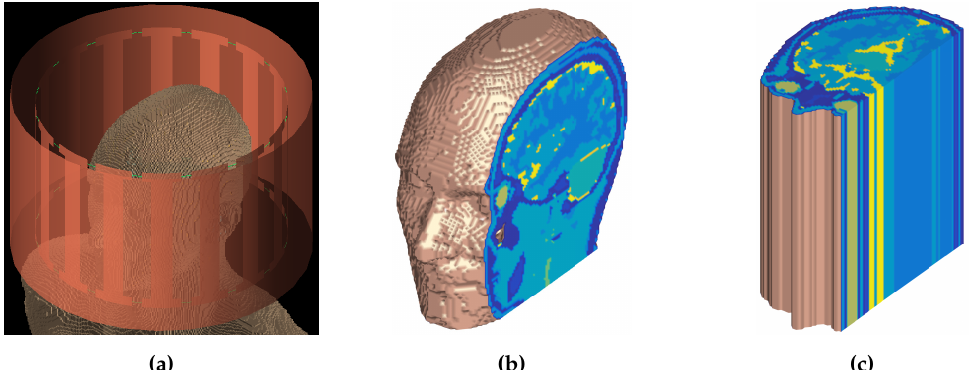
Figure 1. Birdcage coil and head models. ( a ) High-pass birdcage coil with the head model placed inside, ( b ) Duke head model from Virtual Family [27], and ( c ) longitudinally uniform head model obtained by repeating the center slice in the longitudinal